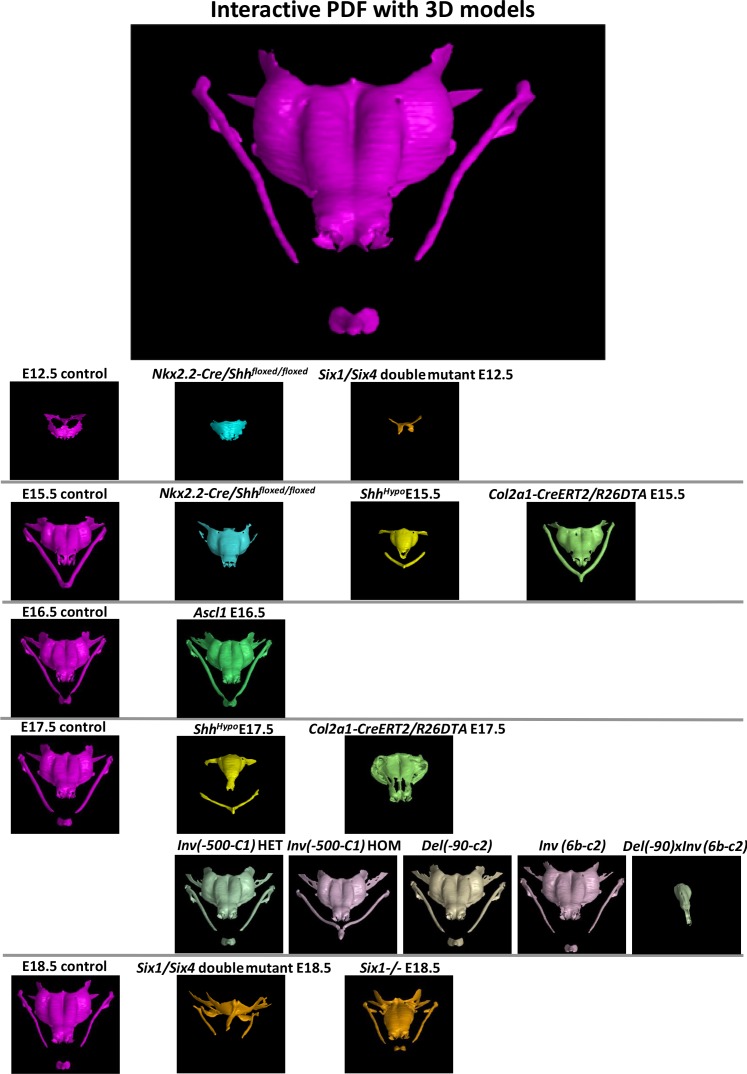
‘Interactive PDF’.Interactive file enables detailed browsing of segmented 3D models of all mutant embryos. Segmented models of cartilaginous nasal capsules of mutants and appropriate controls: Nkx2.2-Cre/Shhfloxed/floxed E12.5 and E15.5 with both control stages; E18.5 Six1/Six4 double knock out with E18.5 control; wild-type E17.5 embryo, Inv(−500 C1) heterozygous embryos, Inv(−500 C1) homozygous embryo, Del(−90 C2) embryo, Inv(6b-C2) embryo, Del(−90 C2)xInv(6b-C2) embryo.